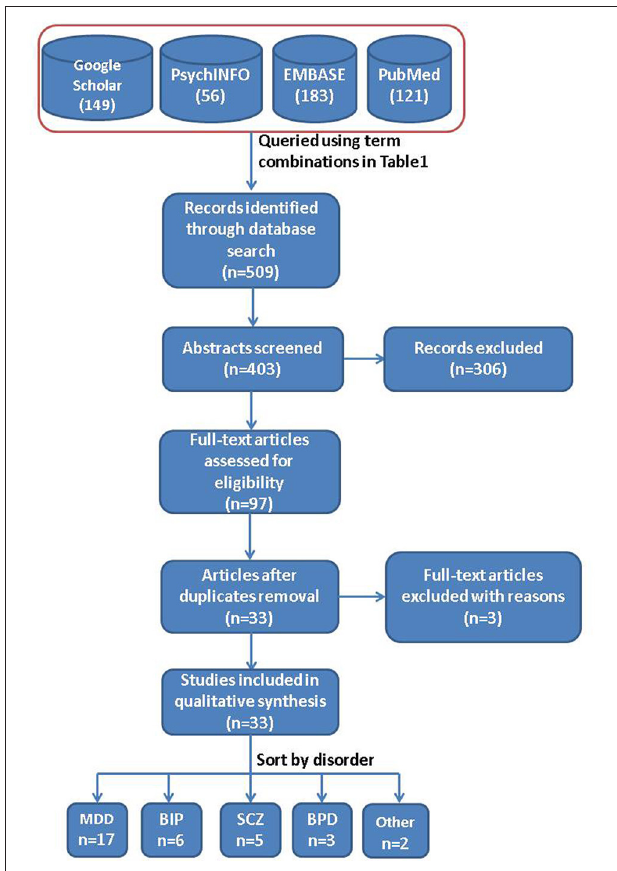
FIGURE 1 | General overview of the methodology. Flow diagram depicting database sources and the steps performed for this systematic